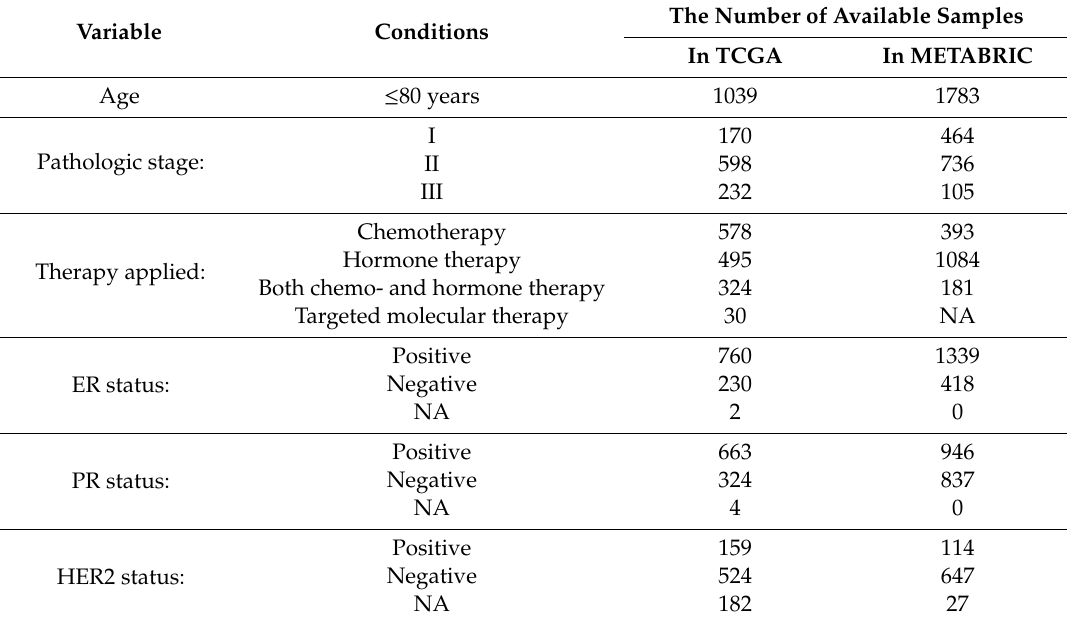
Table 5. A summary of the samples available in the TCGA and METABRIC